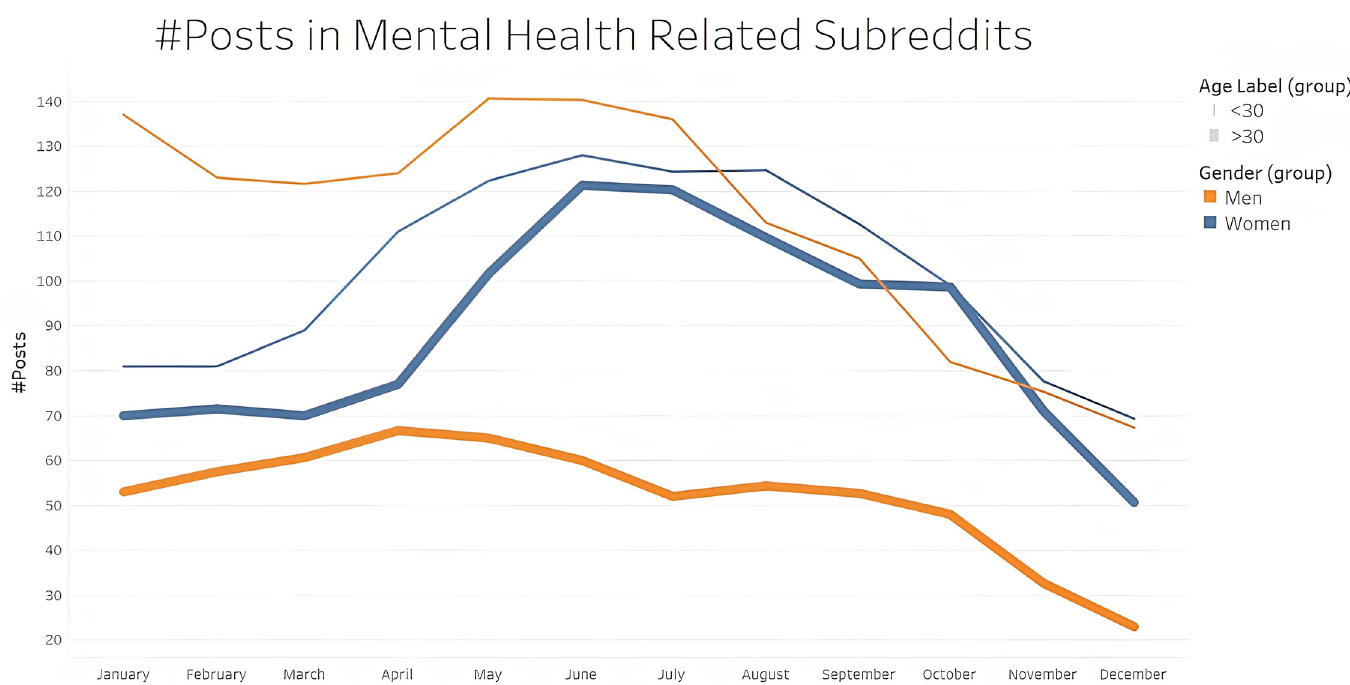
Fig 2. Change in number of mental-health related posts in 2020 based on age and gender. The orange and blue lines represent women and men respectively. The thin lines are for people below 30 years of age and the thick lines are for people above 30 years of age. Mental health related posts are far more by younger people than older, irrespective of